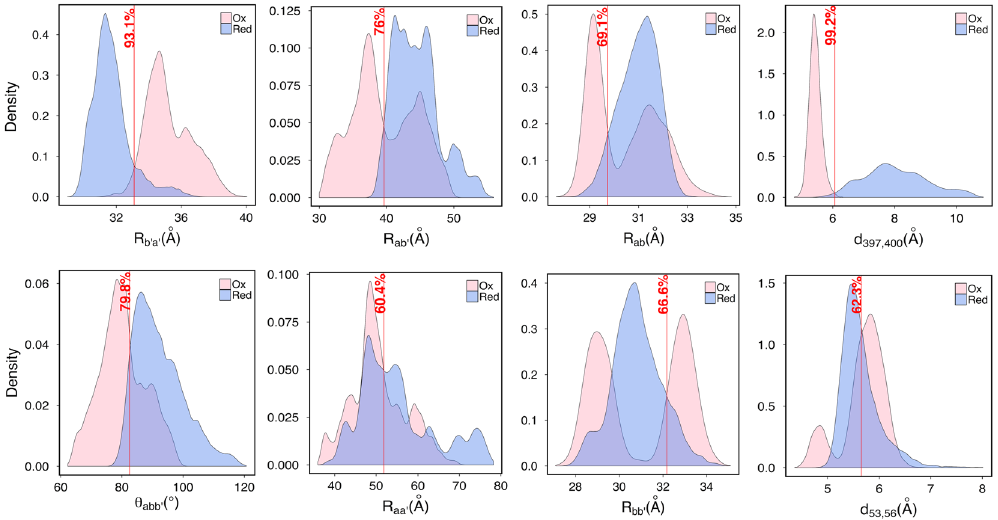
Figure 5. Domain and residue level distance distributions and their discrimination accuracies between the oxidized and reduced states of hPDI. Vertical red lines represent discrimination accuracy percentage. R: Domain distance; d: Residue distance; θ : Inter-domain